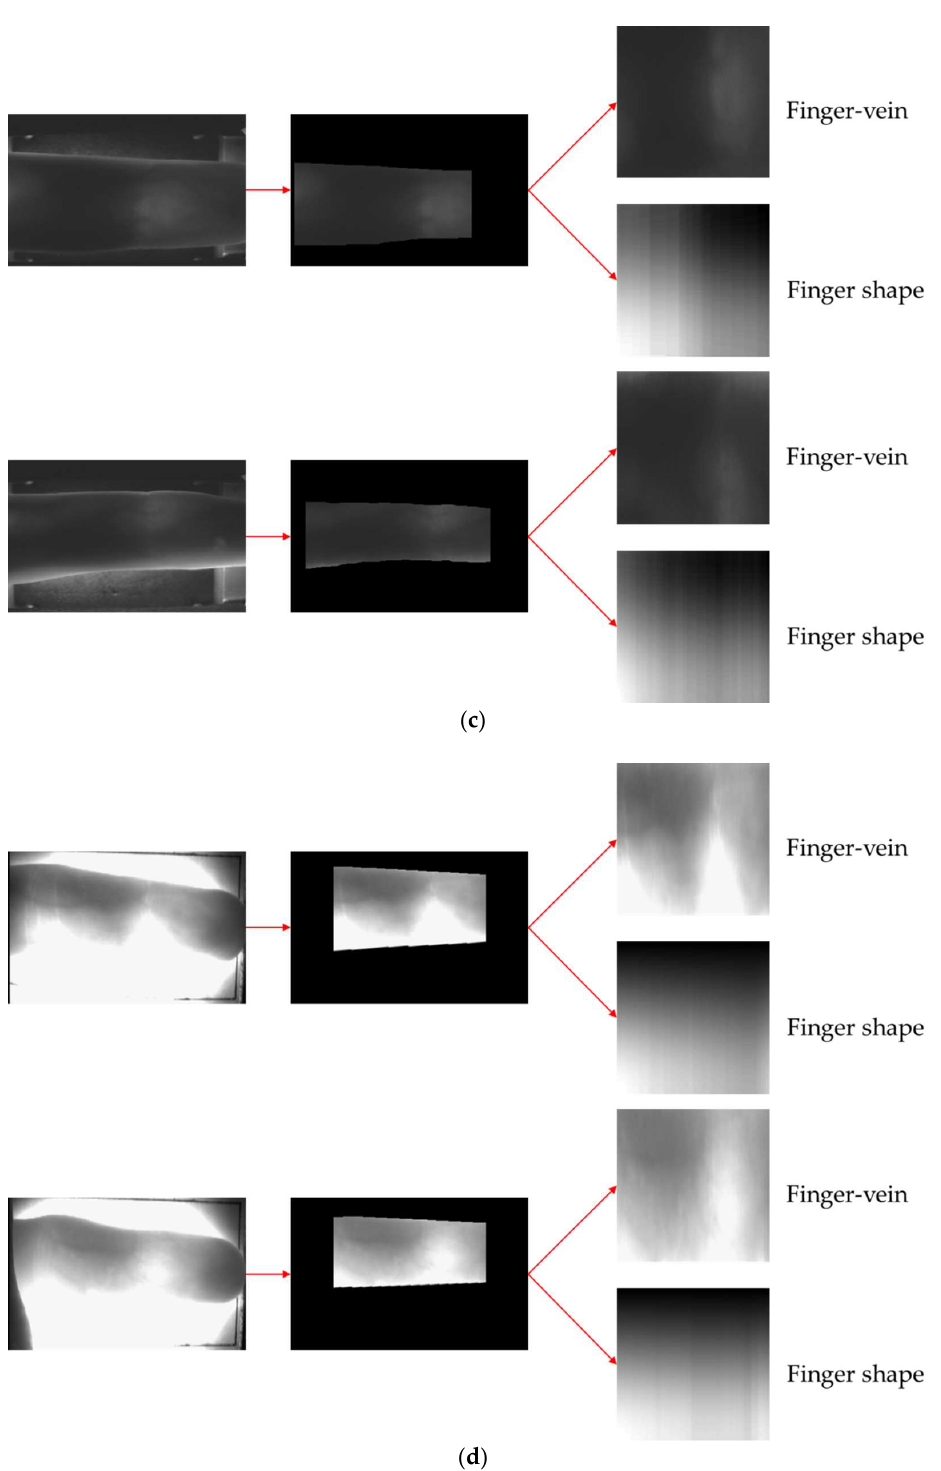
Figure 14. Examples of incorrect recognition cases. ( a , b ) False rejection cases with SDU-DB and PolyU-DB, respectively. ( c , d ) False acceptance cases with SDU-DB and PolyU-DB, respectively. In ( a – d ), upper and lower images show the enrolled and input images, respectively. In ( a – d ), left and middle images present the input and corresponding finger ROI. The right-upper images show that for obtaining the difference image for finger-vein recognition whereas the right-lower images present the spectrogram images for finger shape recognition .